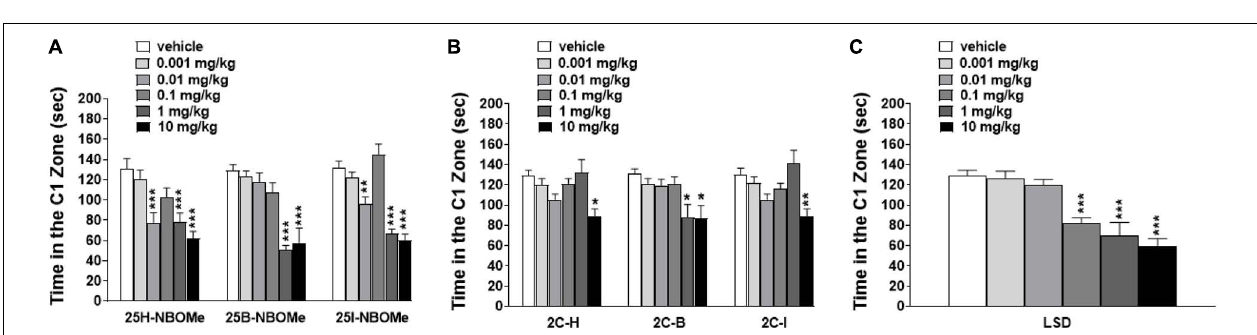
FIGURE 8 | Effect of 25H-NBOMe (0.001–10 mg/kg i.p.), 25I-NBOMe (0.001–10 mg/kg i.p.), and 25B-NBOMe (0.001–10 mg/kg i.p.) (A) ; 2C-H (0.001–10 mg/kg i.p.), 2C-I (0.001–10 mg/kg i.p.) and 2C-B (0.001–10 mg/kg i.p.) (B) ; and LSD (0.001–10 mg/kg i.p.) (C) on the time spent in the C1 zone of mice during the 4-h observation period. Data are expressed as seconds and represent the mean ± SEM of 8 determinations for each treatment. Statistical analysis was performed by one-way ANOVA followed by Bonferroni’s test for multiple comparisons for the dose–response curve of each compound at different times. * p < 0.05, ** p < 0.01, *** p < 0.001 vs.